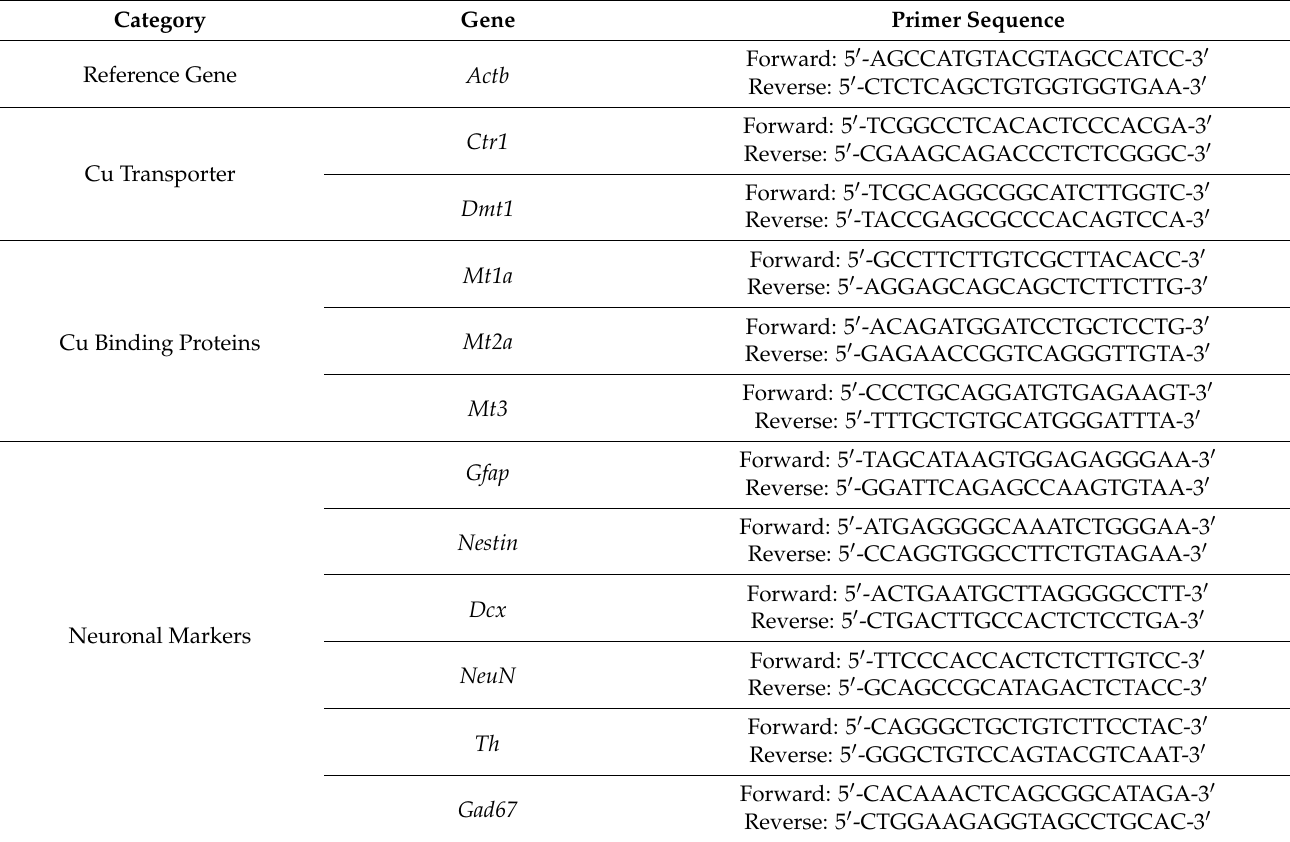
Table 1. The forward and reverse primer sequences of target